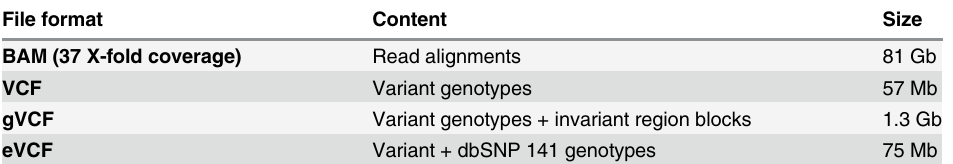
Table 5. Comparison of the content and size of different standard file formats for the storage of geno- mic data.